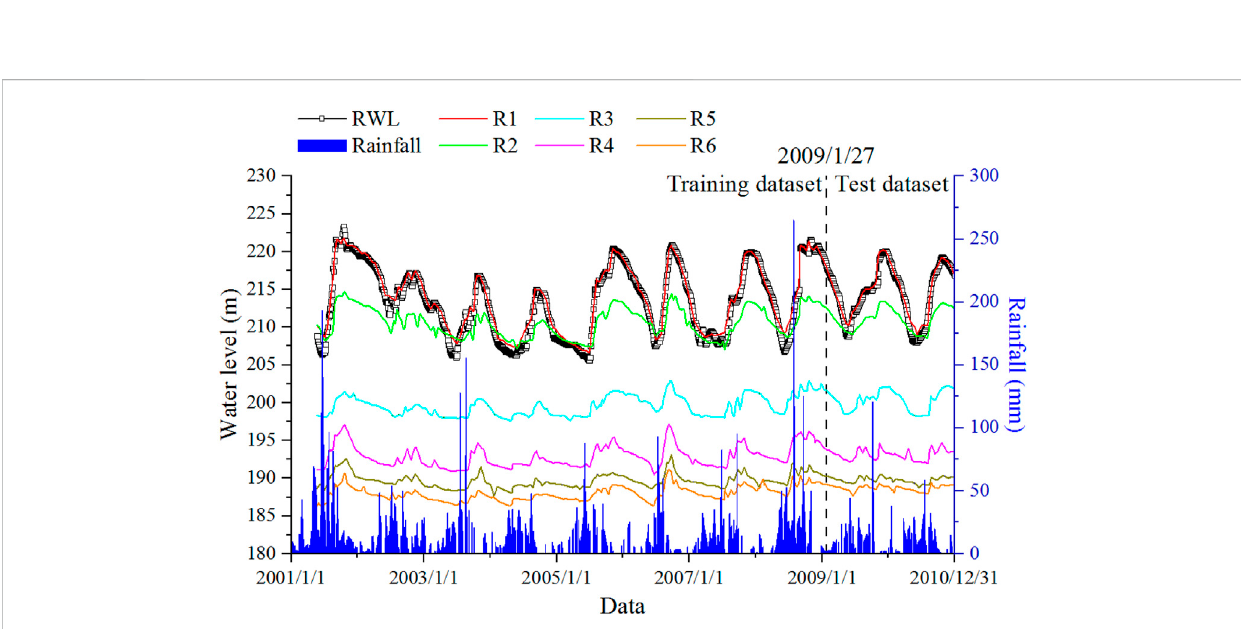
FIGURE 5 Time series of monitoring